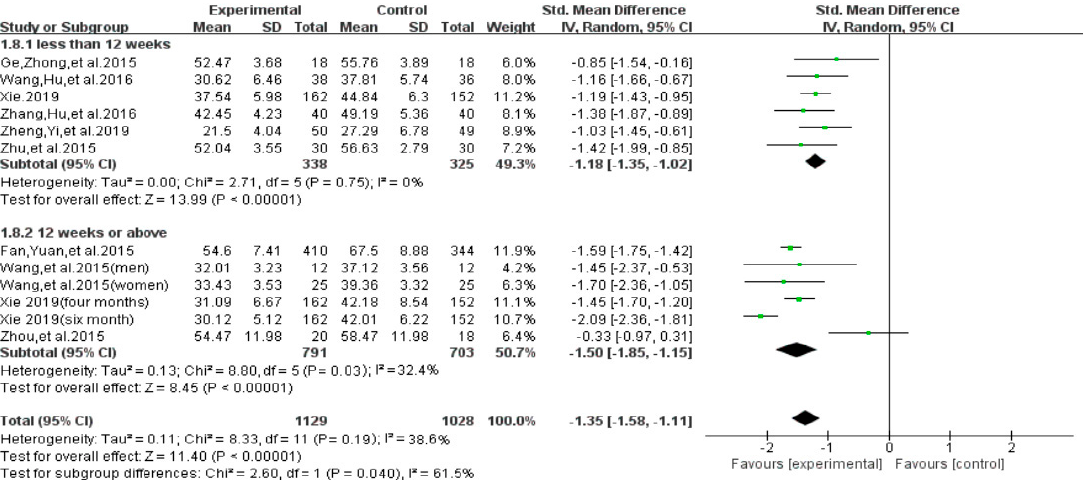
Figure 13. E ff ect of intervention duration on smartphone addiction patients. Figure 13. Effect of intervention duration on smartphone addiction patients.